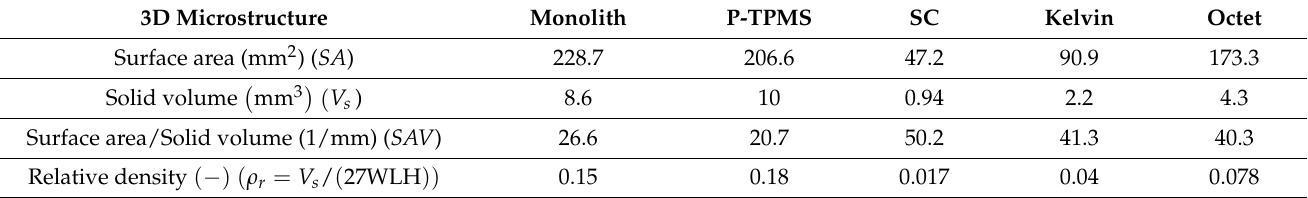
Table 1. Physical characteristics of the used structures (simple cubic, SC; Schwarz Primitive triply periodic minimal surface, P-TPMS; width, W; length, L; height,